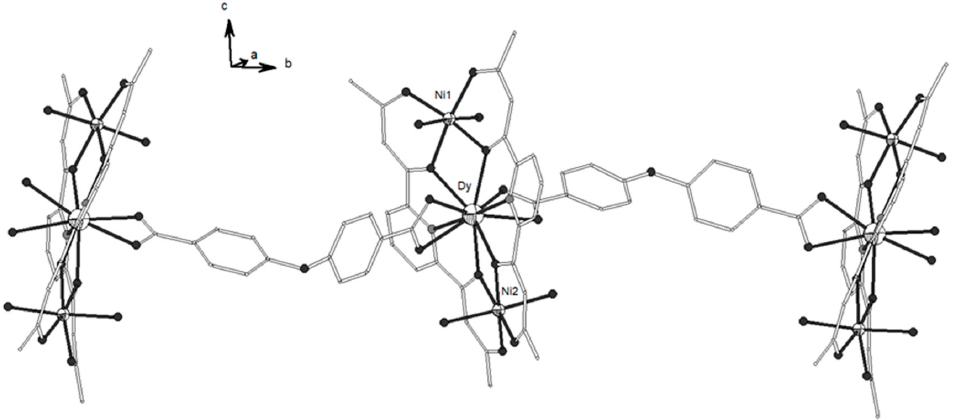
Figure 20. Part of the 1D structure of 165 . Color code as in Figure 19 [58].